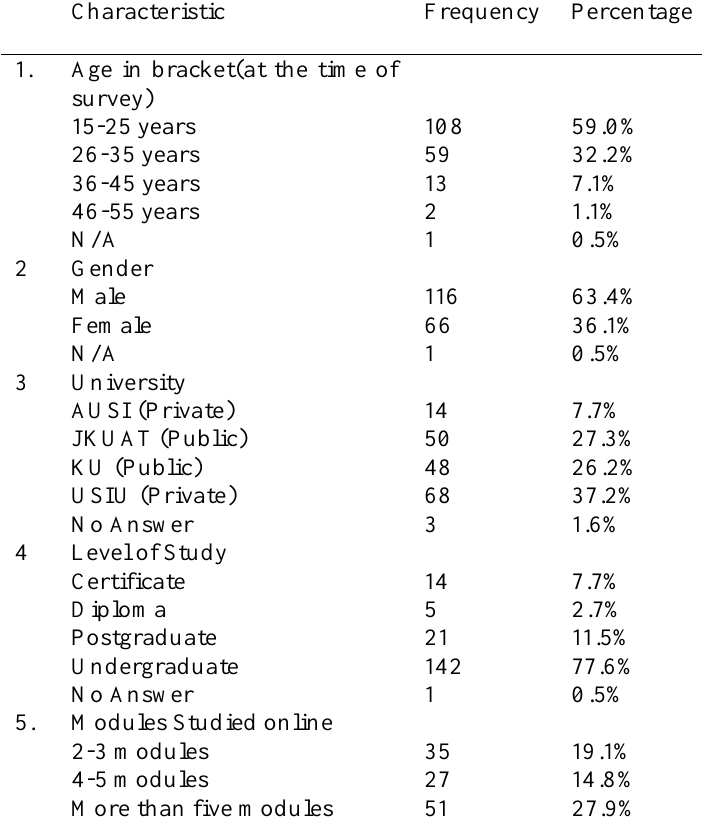
Demographic Information of the Sample (N=183) Characteristic Frequency